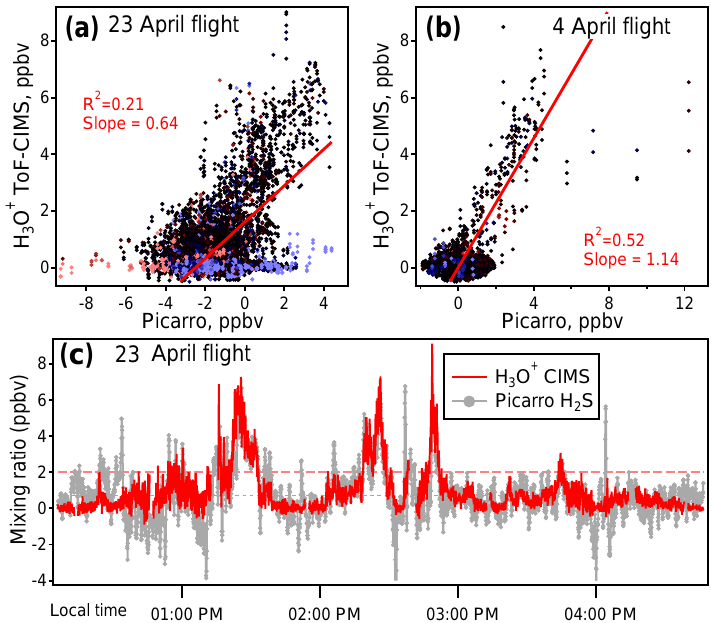
Figure 15. Scatterplot and time-series H 2 S comparison between H 3 O + ToF-CIMS and Picarro CaRDS instruments. (a) Scatterplot of H 3 O + ToF-CIMS vs. Picarro H 2 S for 23 April flight (Permian). Data points when the aircraft was ascending (red) and descending (blue) are highlighted. (b) Scatterplot of H 3 O + ToF-CIMS vs. Picarro H 2 S for 4 April flight (Haynesville). (c) Time series during the 23 April flight. The H 3 O + ToF-CIMS measurement has been averaged to a 6s time basis. The Picarro H 2 S is offset by 2ppb (the intercept in panel a ). The 1 and 6s detection limits for the H 3 O + ToF-CIMS are shown by dashed red